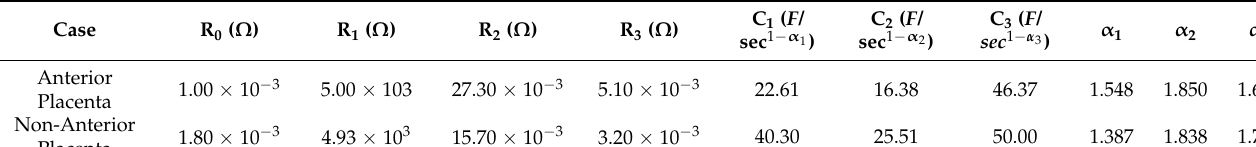
Table 2. Component estimated values for H ( s ).